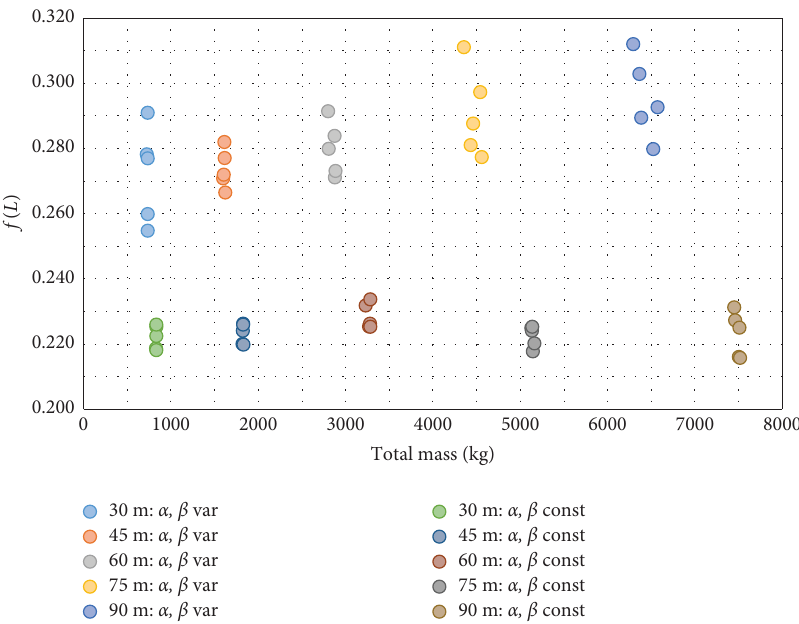
Figure 4: Five best values of ratio f / L at variable and constant angles α and β for all spans.